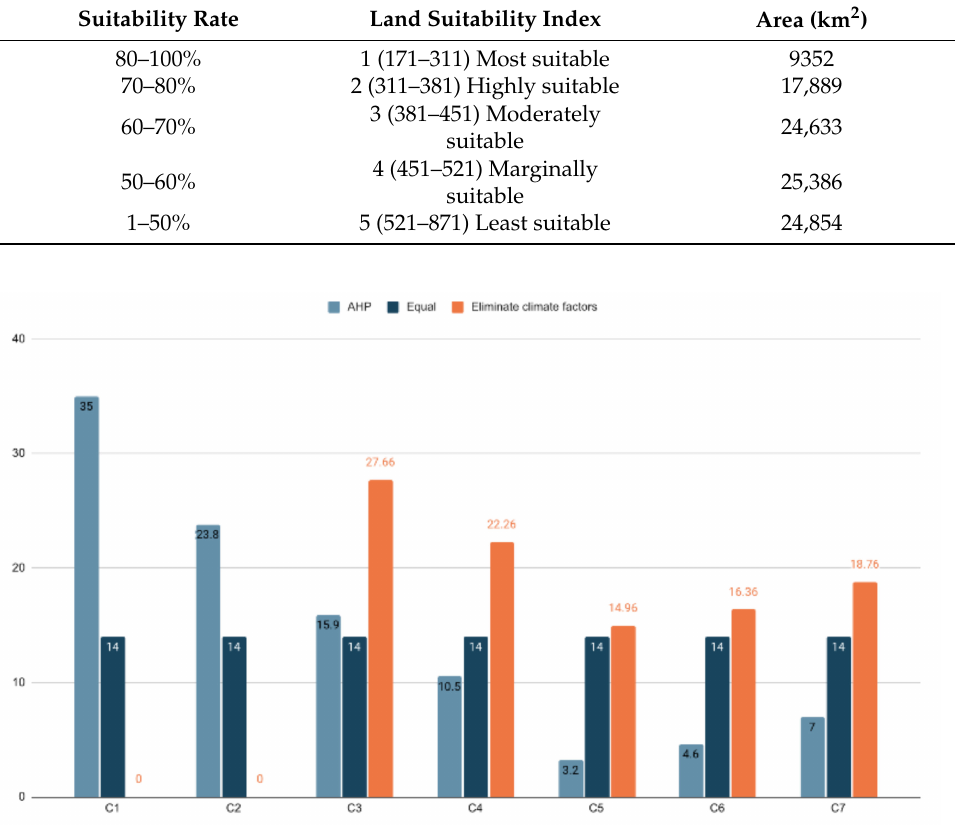
Figure 12. Weights of decision criteria considering different